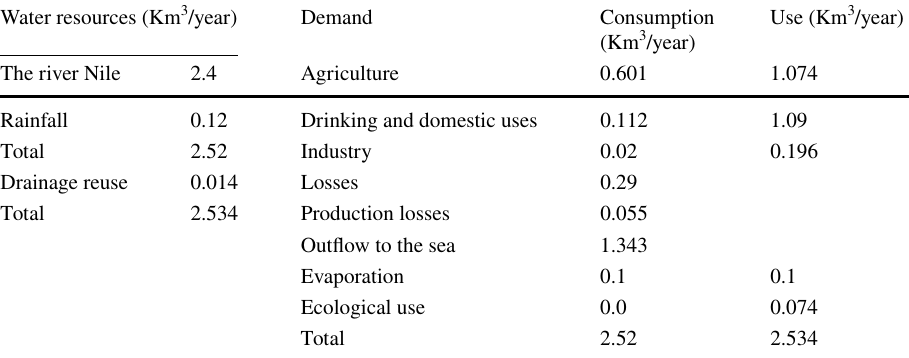
Table 3 The water balance for Alexandria Governorate (Al-Zayed